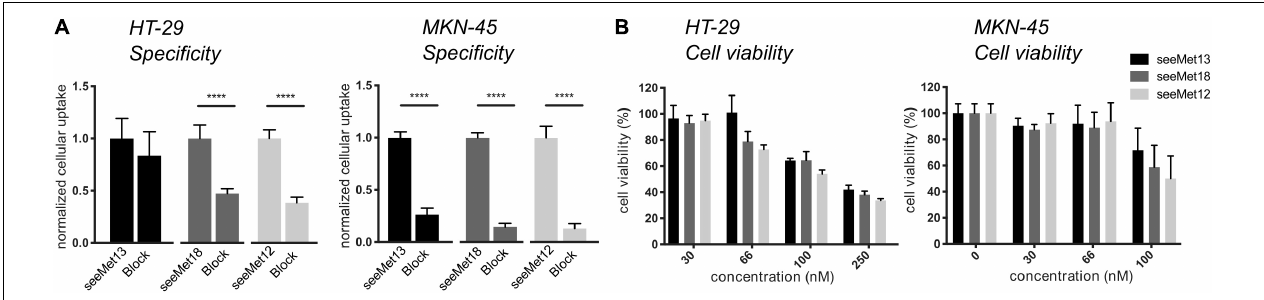
FIGURE 1 | Characterizations of the antibodies seeMet 13, seeMet 18 and seeMet 12 on two gastrointestinal cancer cell lines (HT-29 and MKN-45). (A) Radioimmunoassays of binding specificity of radiolabeled seeMet 13, seeMet 18 seeMet 12 with and without the presence of a > 20-fold molar excess of corresponding unlabeled antibody. N > 3. Error bars represent standard deviation (SD). (B) XTT viability assays. Data has been normalized to viability for untreated controls (100%). N > 3. Error bars represent standard deviation (SD). Considered to be statistically significant * p < 0.05, ** p < 0.01, *** p < 0.001, **** p <